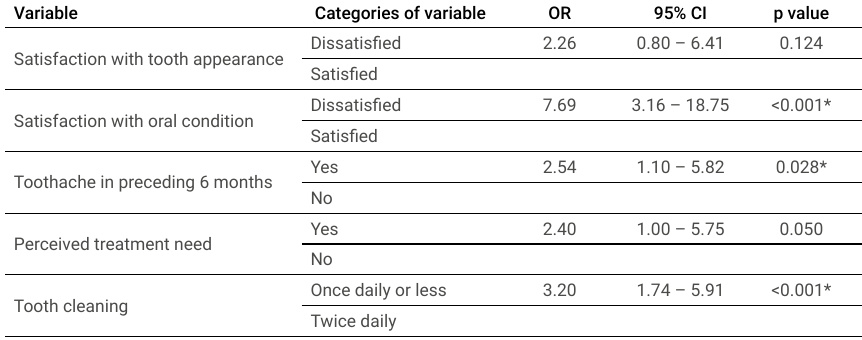
Table 2. Logistic regression analysis of relationship between non-clinical factors and self-rating of oral health status of the respondents